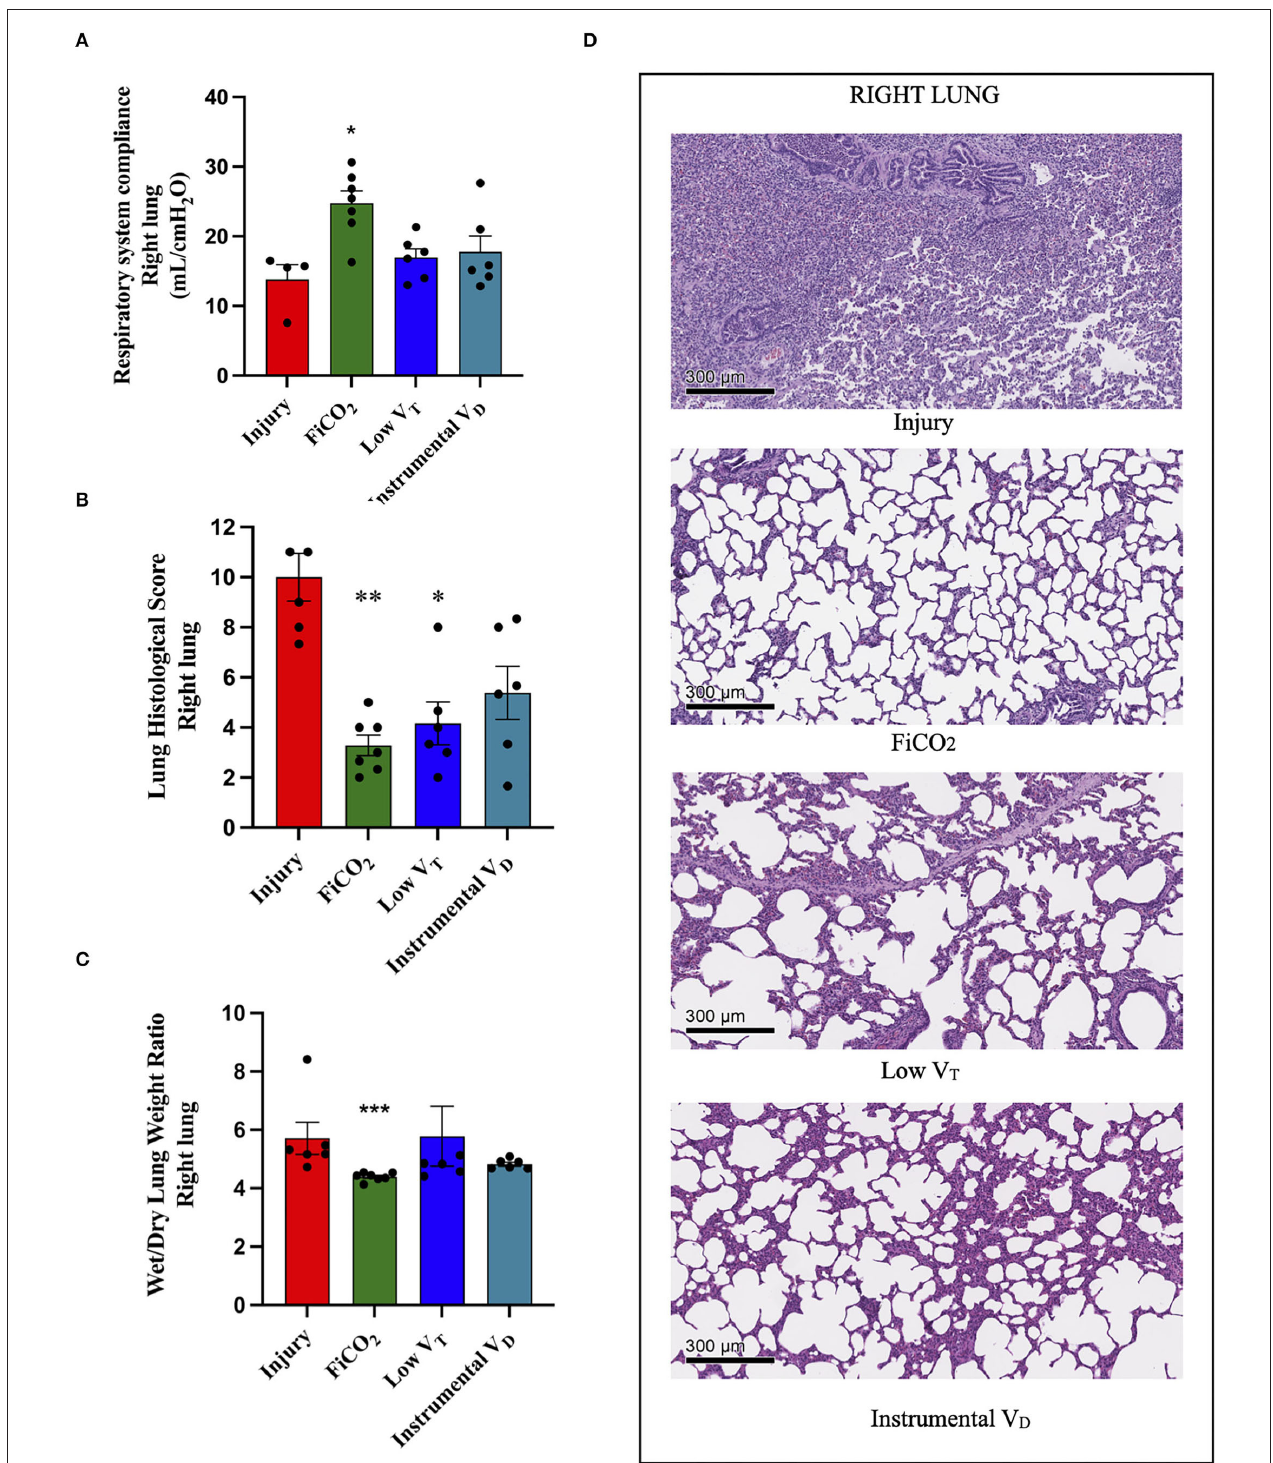
FIGURE 4 | Right lung injury. Right-side respiratory system compliance at the end of the experiment (A) . Histological score of right lungs from each study group (B) . Wet-to-dry of right lungs (C) . Microscopic appearance of the lungs at the end of the experiment (D) . representative microphotographs of the right lungs from the four study groups (H&E, original magnification 100 × ). Data are expressed as scatter dot plots with mean ± SEM. Comparisons are obtained with ordinary one-way ANOVA or Kruskal–Wallis test for normally and non-normally distributed values, respectively, followed by Dunnett or Dunn’s multiple comparison test. * p < 0.05, ** p < 0.01 vs. Injury group, and *** p < 0.001 vs. Injury group.